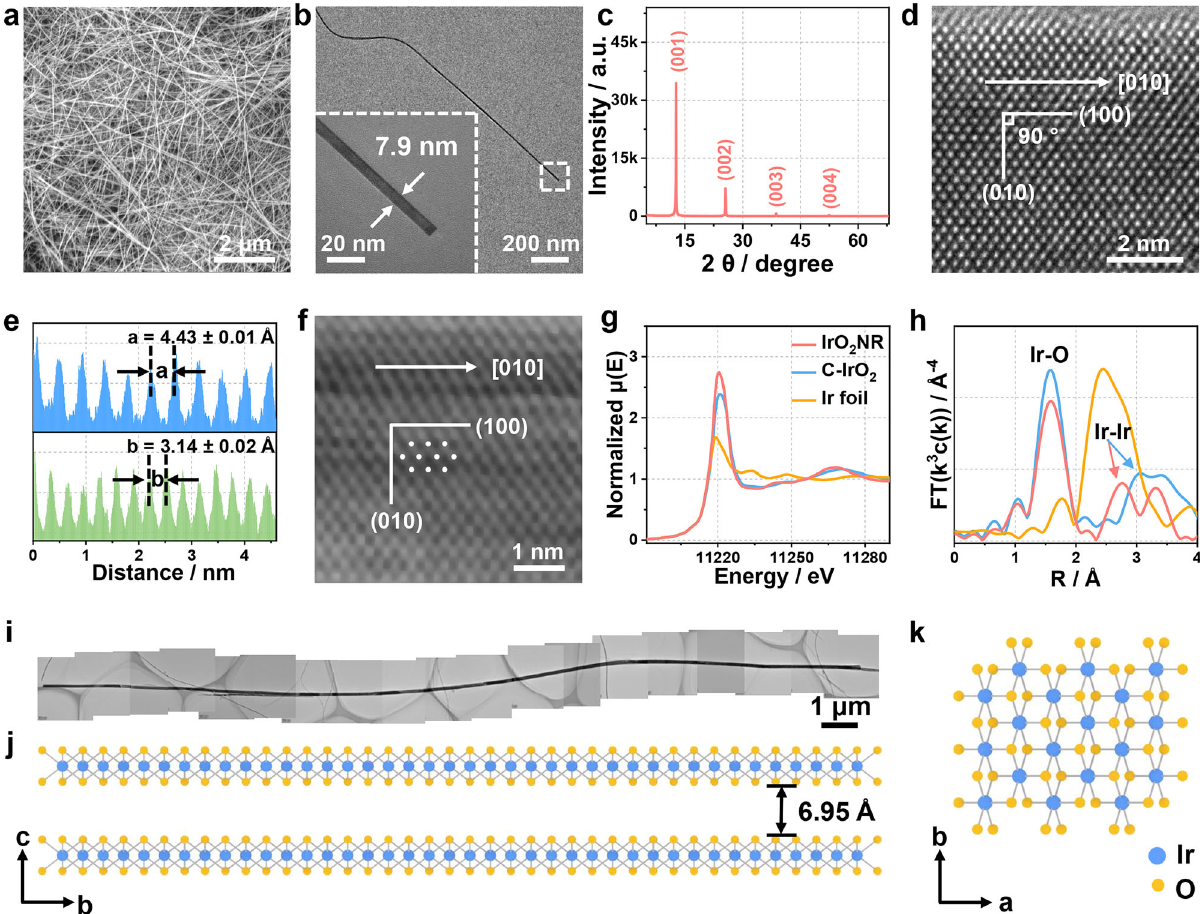
Fig. 1 | Morphology and structure of the IrO 2 NR. a SEM image showing the uniformdistributionoftheIrO 2 NR. b TEMimageofasingleIrO 2 NR.Theinsertisthe enlargement of the tail end of the ribbon with a width of 7.9mm. c XRD pattern. d HRTEM image. e Line scan ofthe HRTEM image indicated by the (100) and (010)